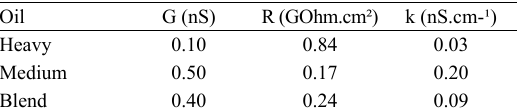
Figure 3. Potentiodynamic polarization of AISI 1020 steel immersed in heavy, medium and blend petroleum, rate scan of 10 mVs -1 . Table 3. Conductance (G), resistance (R) and conductivity (k) calculated from the potentiodynamic polarization for AISI 1020 steel in heavy, medium and blend petroleum.